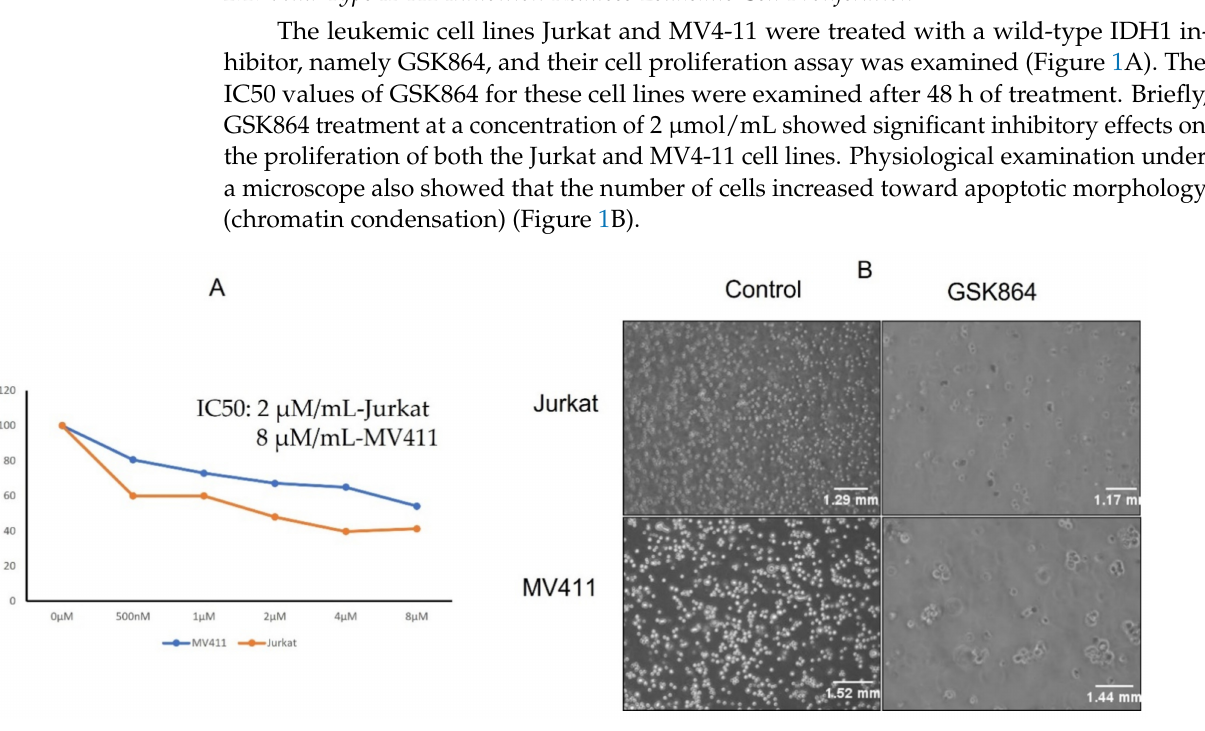
Figure 1. GSK864 treatments reduced cell proliferation and altered cellular morphology ( A , B ). MTT assays were performed to determine cell viability upon treatment with different concentrations of GSK864 for 48 h in both Jurkat and MV4-11 cells. All the images were captured using a Nikon phase contrast microscope at 20 × . p <